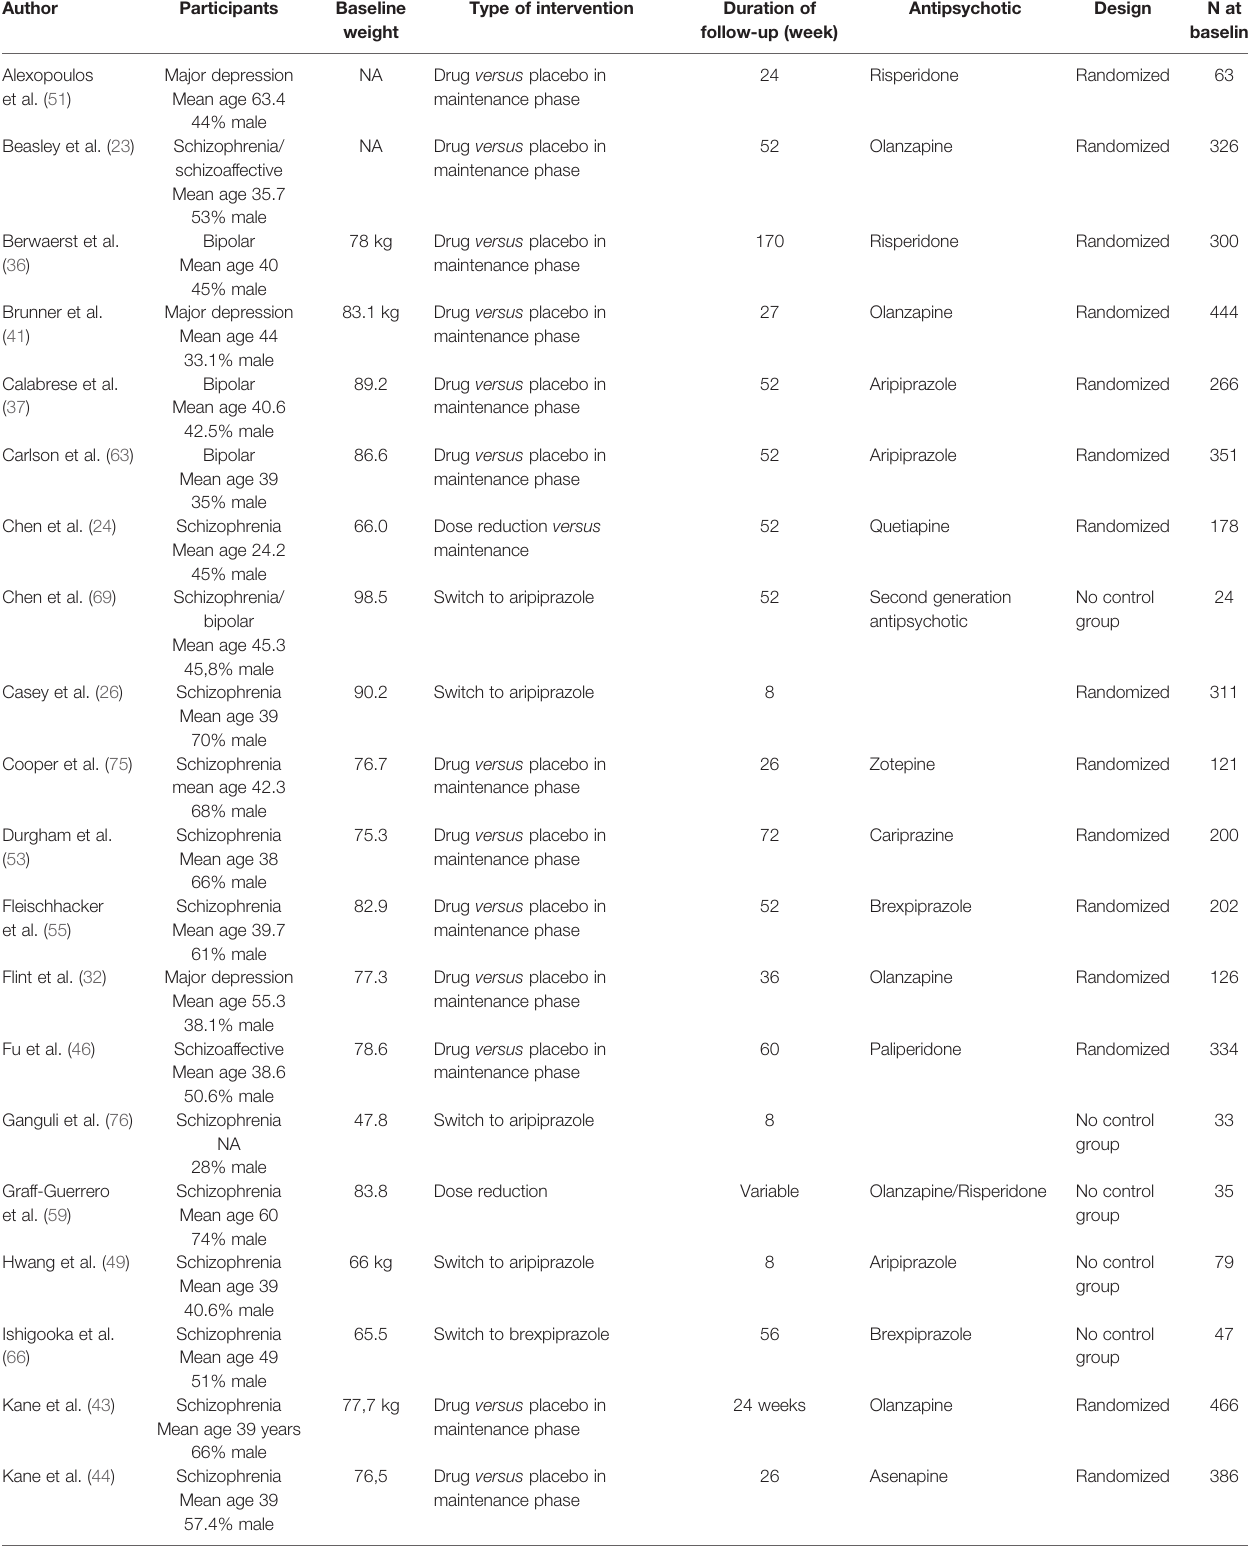
TABLE 1 | Characteristics of included